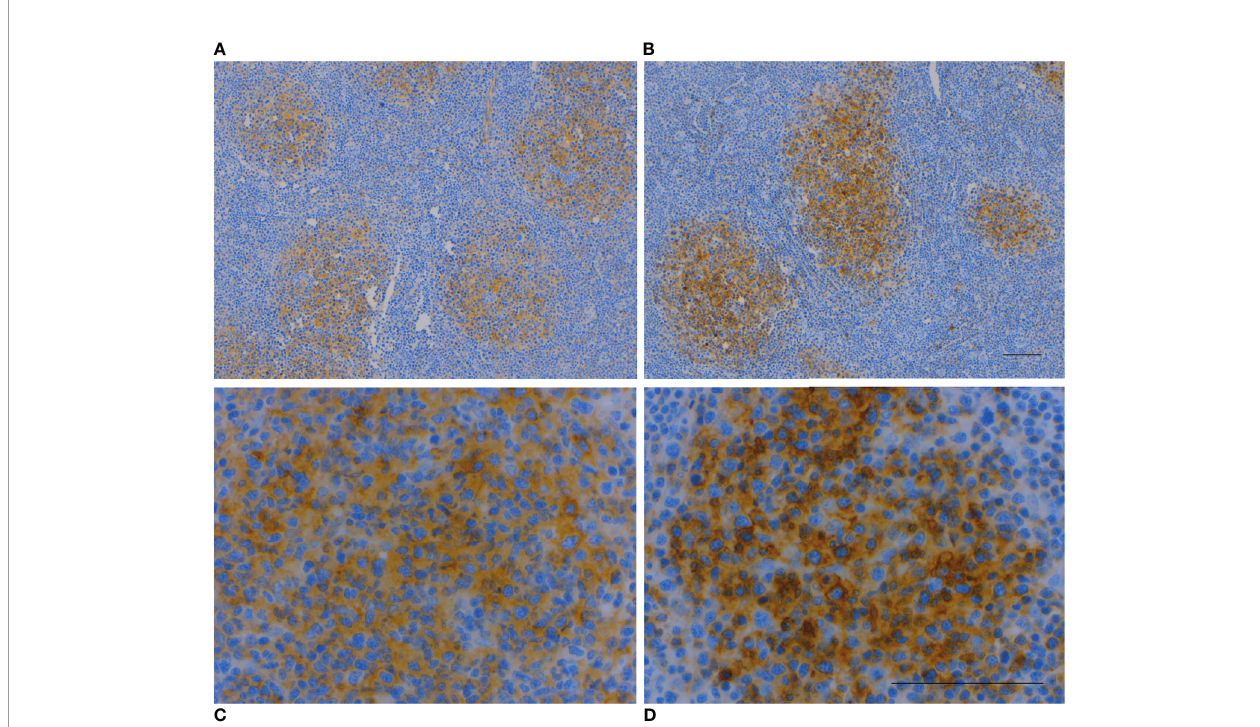
FIGURE 3 | SSTR2 IHC (A, C) and CXCR4 IHC (B, D) were mildly-to-moderately positive in the cytoplasm and cell membrane in 70% of malignant B-cells in a patient with FL (no. 73). Follicular dendritic cells were also positive. Scale bar=100